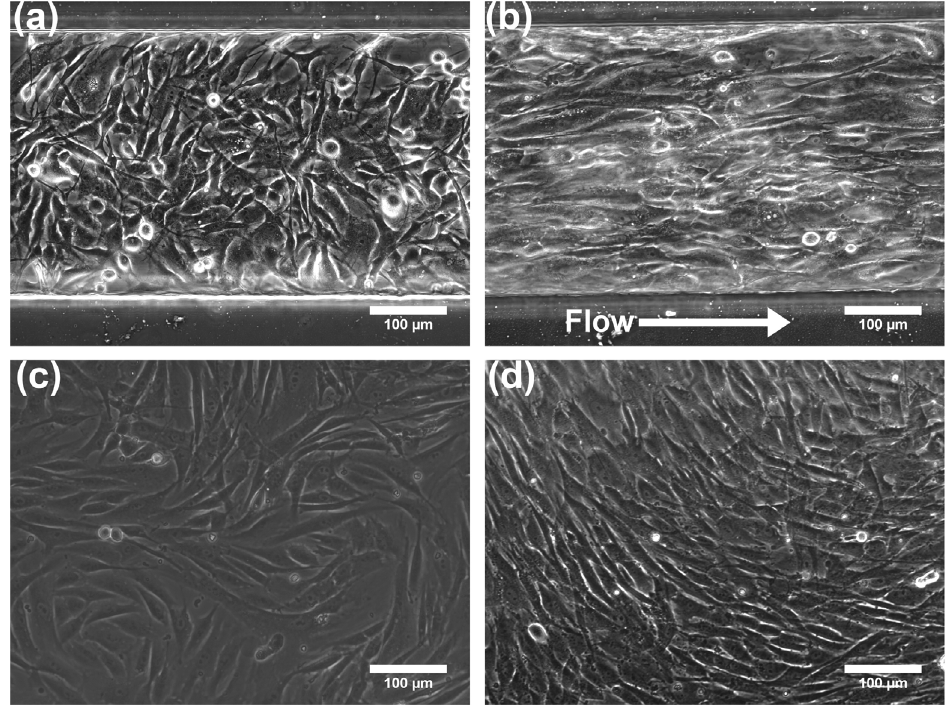
Figure 3. Effect of shear stress on MSC alignment. Phase contrast images of MSCs cultured within the microfluidic device on ( a ) day 1 (just after attachment and before the start of flow) and ( b ) day 4 under a shear stress of 0.1 dynes/cm 2 . Phase contrast images of MSCs cultured in static conditions (0 dynes/cm 2 , polystyrene cell culture treated petri dish) on ( c ) day 1 and ( d ) day